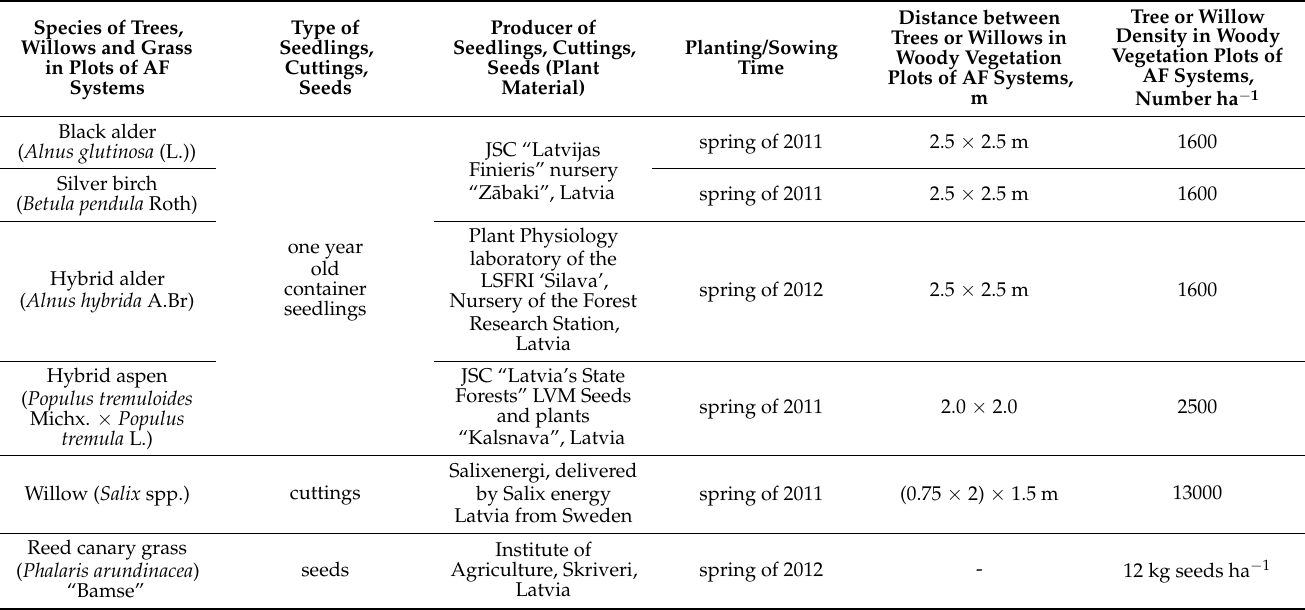
Table 2. Study site design and characterisation of tree seedlings, willow cuttings and RCG